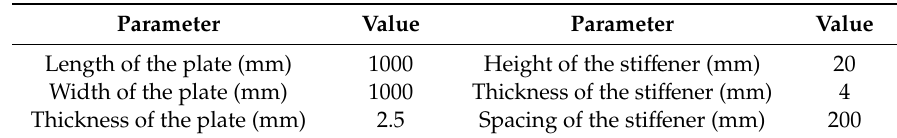
Table 1. Parameters of the test plate.